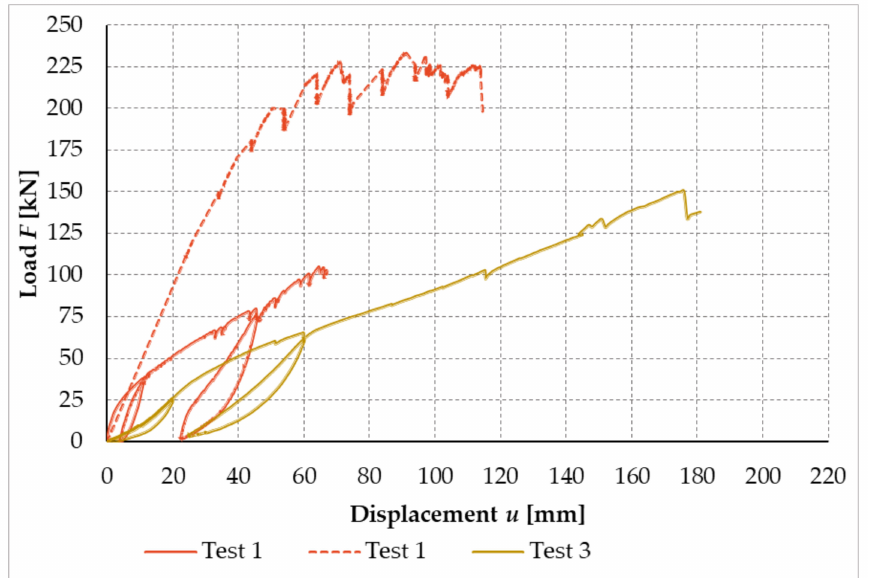
Figure 24. Load–displacement curves of experimental testing, test sample no. 1 and test sample no. 3 (experiment setup no. 2).